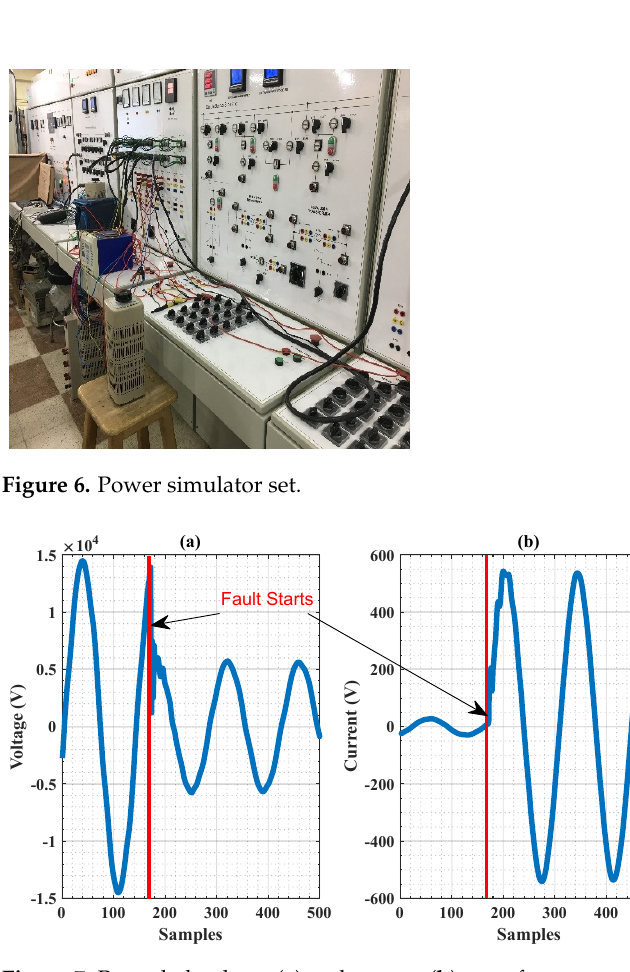
Figure 7. Recorded voltage ( a ) and current ( b ) waveforms.